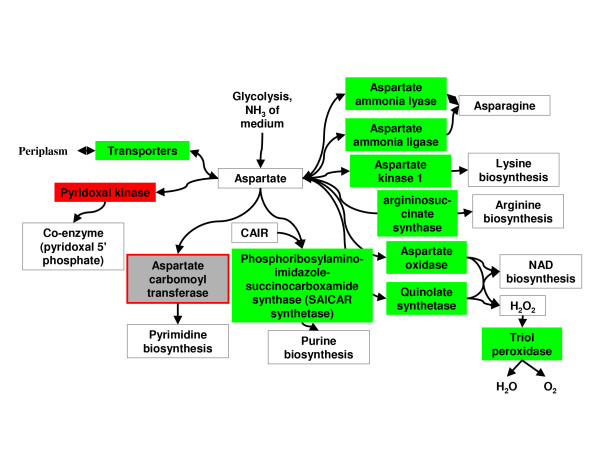
Fourth and tenth extracted sub-graph. It shows the enhanced regulation of some reactions metabolising aspartate in accordance to a higher abundance of aspartate during oxygen deprivation (see text). Aspartate carbamoyl transferase was slightly, but not significantly down-regulated (p-value: 0.16). For box colours see legend of Figure 3.